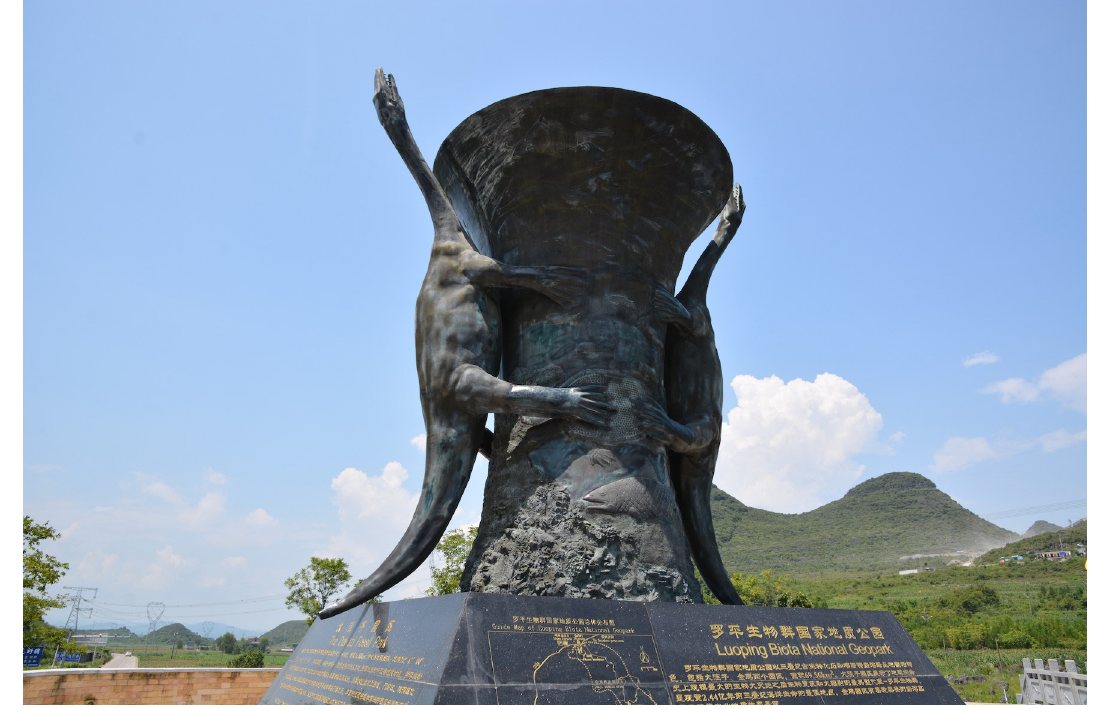
Figure 14. Bronze marker at the entrance to the Luoping Biota National Geopark on the new expressway. The sculpture shows a traditional Chinese vessel, covered with a sculpted scene of the seabed with neopterygian fishes, and notho- saurs forming handles on either side. Photograph by